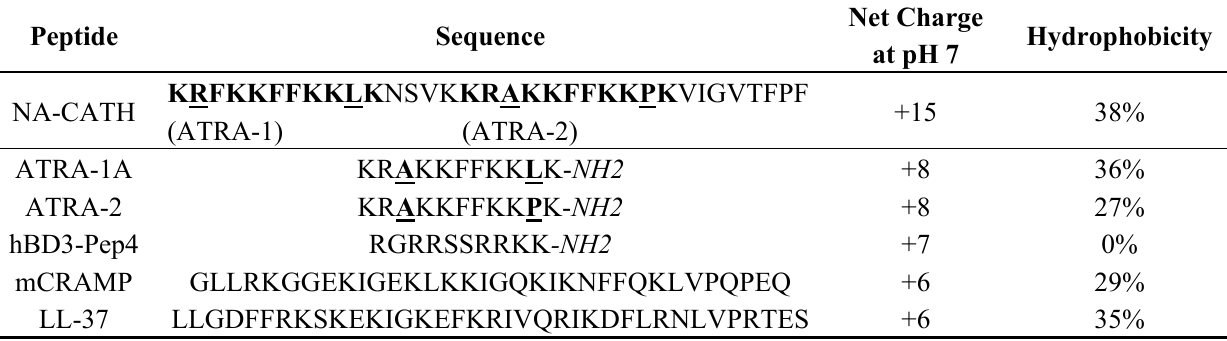
Table 1. Sequences and net charges of tested antimicrobial peptides. Short peptides contain a C-terminal carboxamide indicated by the italicized “-NH2”.